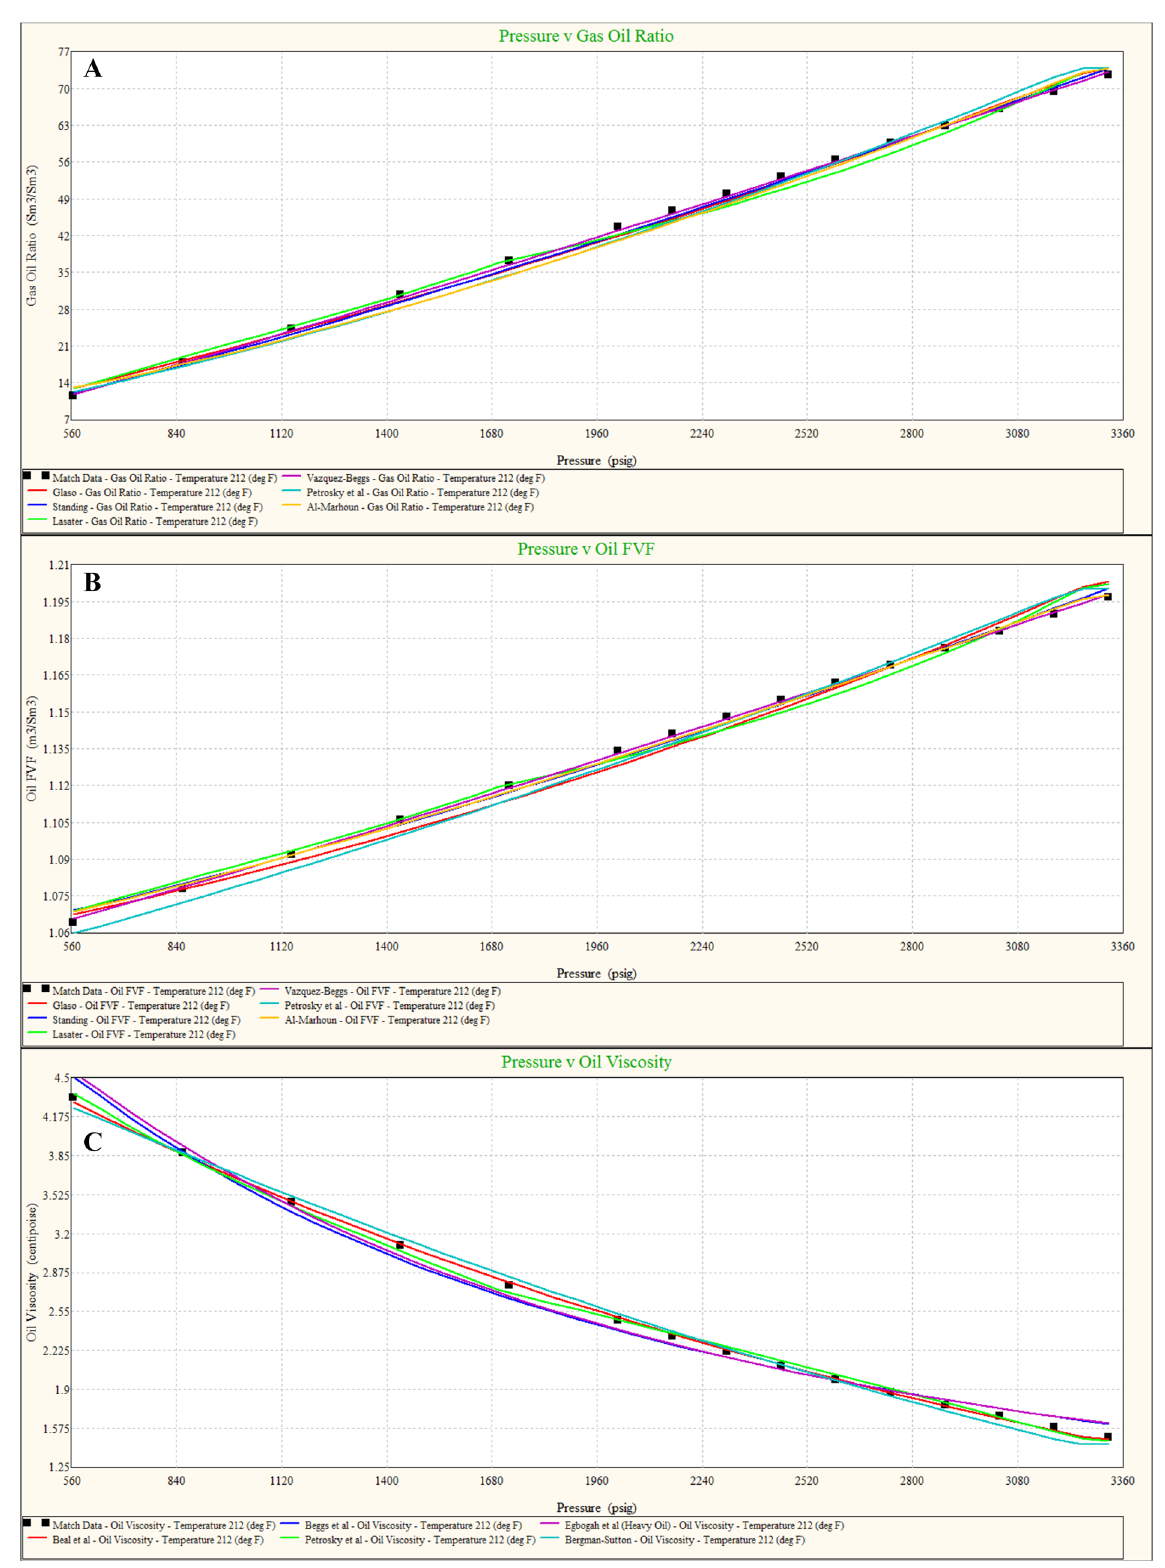
Fig. 2 a Compliance of gas/oil ratio with empirical relationships. b Matching of the oil formation volume factor with empirical relationship; c compliance of the viscosity laboratory data to the empirical